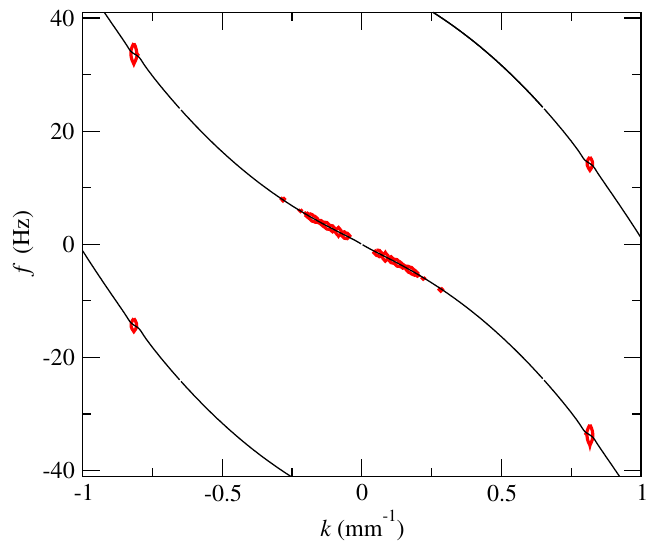
Figure 7. Contour plot (thick lines) of the dispersion map of the solution of Equation(1) computed over the time interval of 3s with a random initial perturbation of the flat film surface. The thickness of the water film is h = 0.6mm and the vibration parameters are a = 0.8 and f = 48Hz, similarly to Figure 4b. The thin solid lines correspond to the imaginary part of the Floquet exponent I m ( λ ) of the most unstable